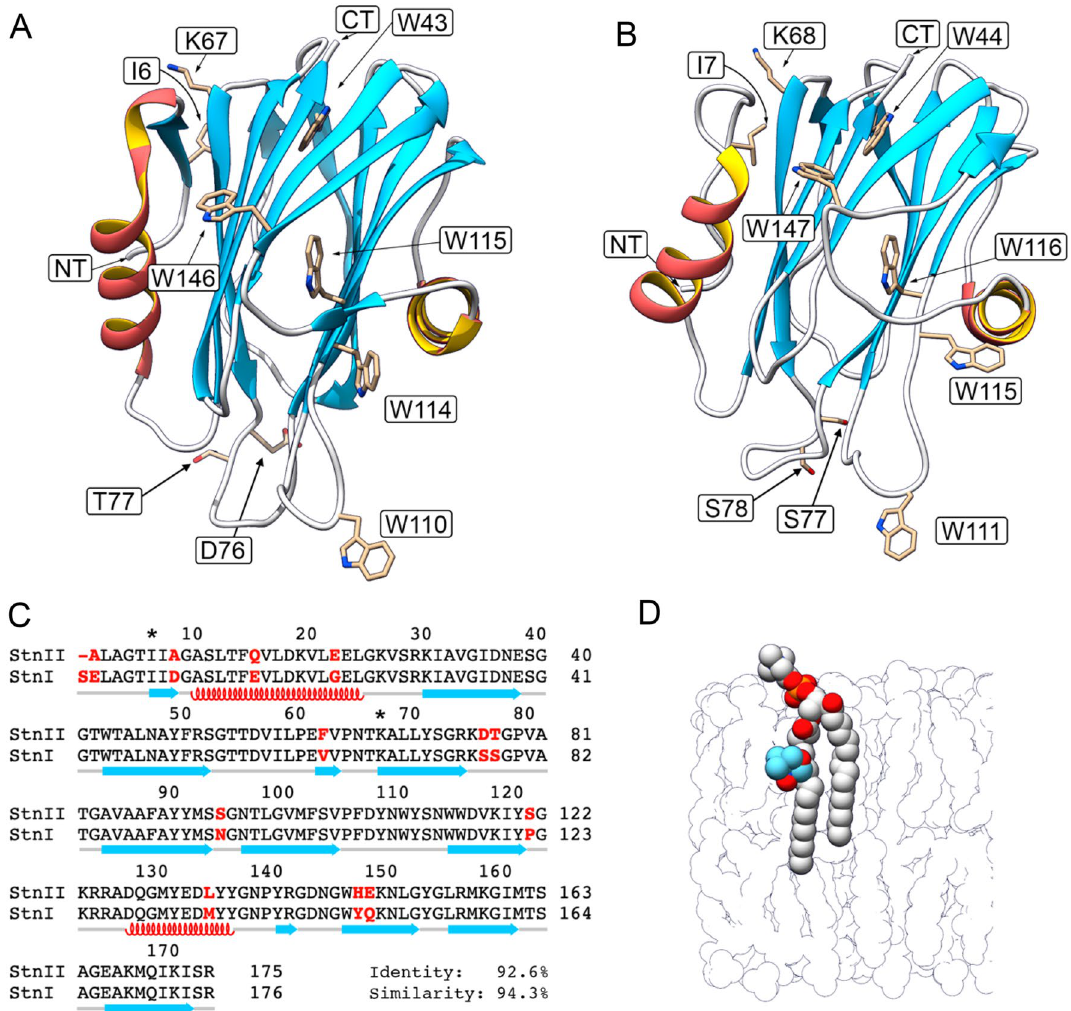
Figure 1. ( A ) The three-dimensional structure of StnII. PDB ID 1GWY. Indicated are all five Trp residues of the protein, plus I6 and K67, which have been mutated to Cys to form a disulfide bridge that prevents the deployment of the N-terminal α-helix. Of all five Trp residues, only W110 and W114 (W111 and W115 in StnI) are inserted in the membrane 35,37 . W43 and W115 are buried in the protein core, and W146 is known to participate in protein–protein interactions upon oligomerization 10,37,39 . The possible role of D76 and T77 is commented in the discussion. ( B ) The three-dimensional structure of StnI. PDB ID 2KS4. Indicated are the same features as in ( A ). ( C ) Sequence alignment of StnII and StnI. Shown are the secondary structure features of Stns. Colors are the same as in ( A ) and ( B ). Differences between StnI and StnII are highlighted in red. Asterisks indicate the positions mutated for this study. ( D ) Sketch of a bilayer in which a molecule of 7-SLPC has been highlighted. The doxyl moiety is shown in blue. Scale between ( A ) and ( B ) and ( D ) is approximately The new mutants, StnI-I7C/K68C and StnII-I6C/K67C were characterized functionally and structurally using circular dichroism, intrinsic fluorescence emission, and hemolytic assays, as previously described 56 . The hemo- lytic activity of the mutants was negligible when oxidized (hereon indicated as StnI-I7C/K68C ox , for example). However, if the disulfides were reduced before exposing the toxin to the erythrocytes, the hemolytic activity was almost completely recovered to the values of the WT variant (Fig. S2). Vesicle preparation. Dry lipid films were prepared from the chosen organic lipid solutions combined in the desired molar proportion, followed by evaporation of the organic solvent under nitrogen flow at 40 °C. These films were then hydrated in buffer (10 mM Tris, 140 mM NaCl, pH 7.4) at 65 °C in a water bath for at least 30 min and suspended by gentle vortex. This method yields symmetric bilayers arranged in multilamellar vesicles, with all lipid species randomly distributed between the leaflets. Suspended lipid vesicles were then extruded at hydra- tion temperature through polycarbonate filters to obtain large unilamellar vesicles (LUVs) of 200 nm average size. According to the manufacturer (Avanti Polar Lipids 57 ), this system is expected to yield samples with low polydispersity, if filters with pore size ≤ 200 nm are used. DLS measurements have confirmed this previously 58 and for the current samples (data not shown). Vesicle symmetry is expected to be maintained in the time